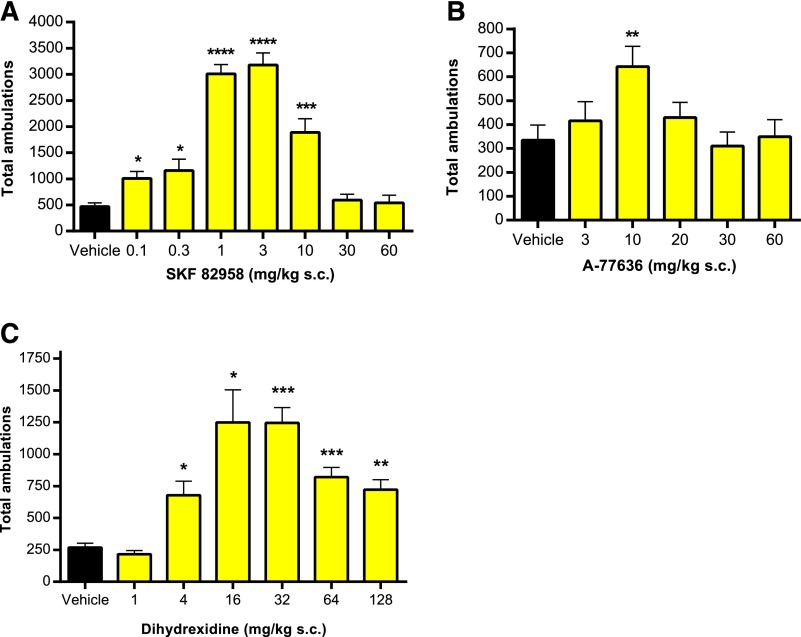
Bell-shaped locomotor responses to the D1 agonists (A) SKF 82958, (B) A-77636, and (C) dihydrexidine. Due to slow onset of activity of A-77636, the values in B are from the second hour after dosing. In A the n values are (from left) 19, 5, 12, 14, 13, 8, 8, 8. In B, n = 14 for all points; and in C, n = 9 for vehicle, n = 6 for all other points. The values for drug-treated animals were compared with vehicle using a two-sided t test: *P < 0.05, **P < 0.01, ***P < 0.001, ****P < 0.0001. In A and C, Welch’s correction for unequal variances was used.